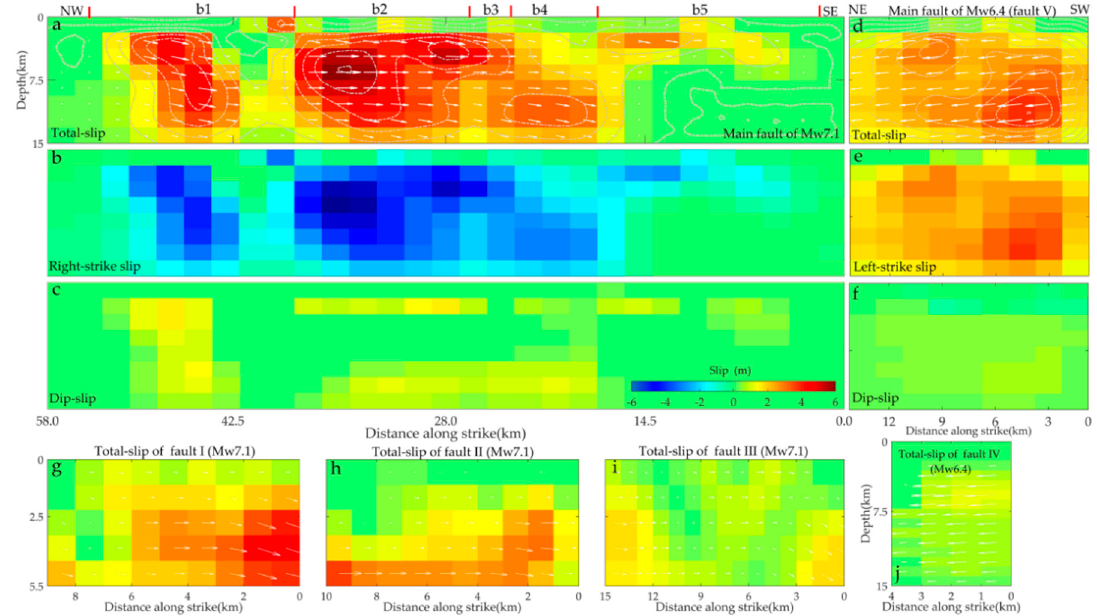
Figure 11. Slip distribution on the multiple faults. The distribution of ( a ) the total-slip, ( b ) strike-slip, and ( c ) dip-slip on the Mw7.1 main fault. The distribution of ( d ) total-slip, ( e ) strike-slip, and ( f ) dip-slip on the Mw6.4 main fault. ( g – j ), The total-slip distribution on ( g ) fault I, ( h ) fault II, and ( i ) fault III of the Mw7.1 event and ( j ) fault IV of the Mw6.4 foreshock. Bends b1–b5 correspond to surface ruptures b1–b5 of the Mw7.1 event.